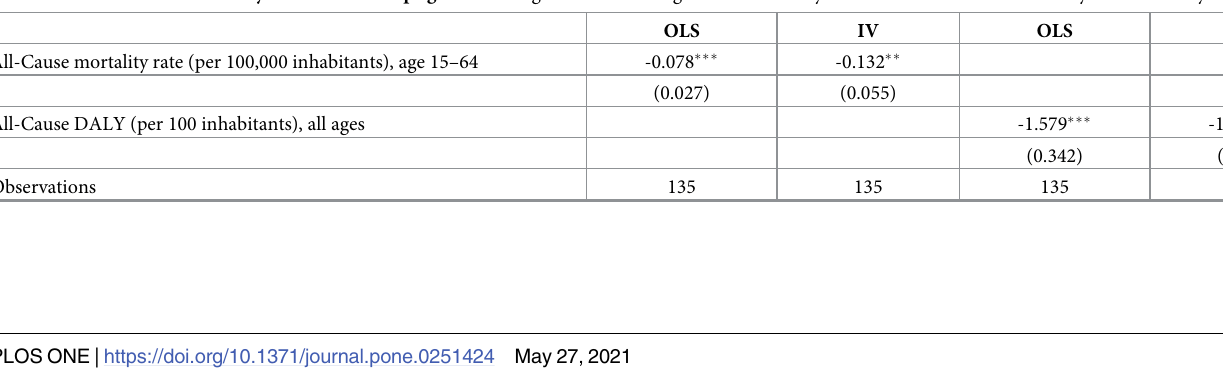
Table A5. The effect of mortality/DALYs on GDPpc growth. Long-Run Growth Regression. Effects by alternative measures of mortality and